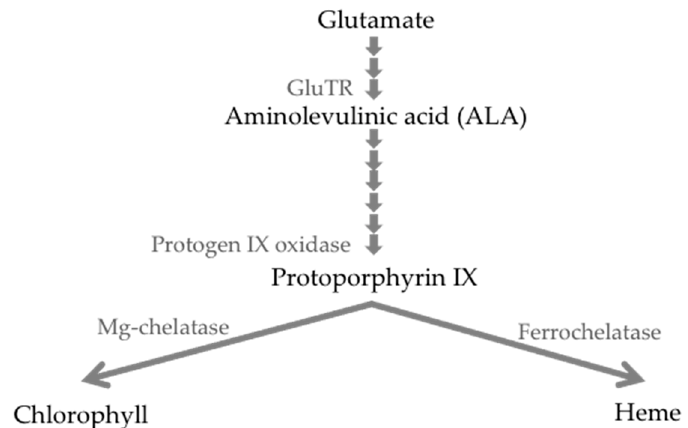
Figure 1. The tetrapyrrole biosynthesis pathway with major end products (bold text) and some catalytic enzymes. GluTR; Glutamyl-tRNA reductase, Protogen IX oxidase; Protoporphyrinogen IX oxidase.